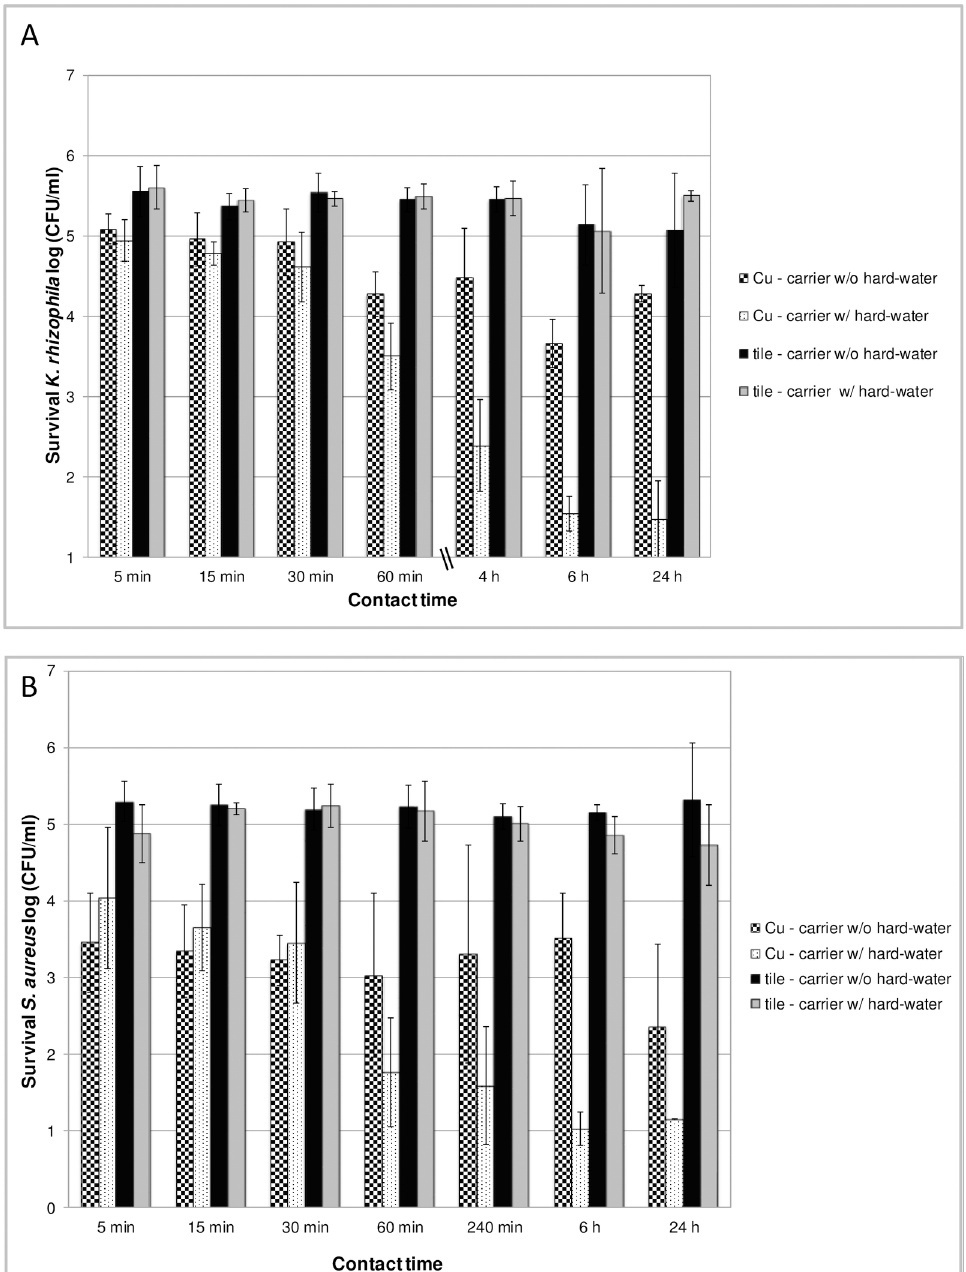
Fig 1. Microbial survival on copper alloy discs (CuSi21Si3P) and tile carriers. Carriers were inoculated with 100 μl bacterial suspension of K . rhizophila (titer: 1.5–5 x 10 7 CFU/ml; Fig 1A ) and S . aureus (titer: 2.4 x 10 7 CFU/ml; Fig 1B ) in the presence of organic soiling (0.3% BSA; 0.3% sheep erythrocytes). After drying for max 60 min, 200 μl standardized hard-water was added to the samples indicated as “w/ hard-water”. Samples indicated as “w/o hard-water” received no addition of standardized hard-water. Microbial survival rates were determined as described in Material and Methods at the intervals indicated and expressed as log CFU/ml. The experiments were repeated at least three times on different days. Mean values are displayed with standard error. The design of the experiments is depicted schematically in S1 Fig.